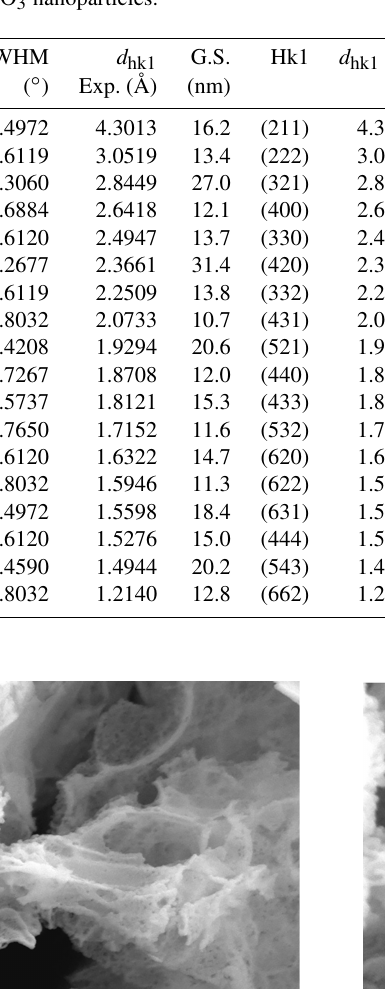
Table 1. XRD parameters of Er 2 O 3 nanoparticles.